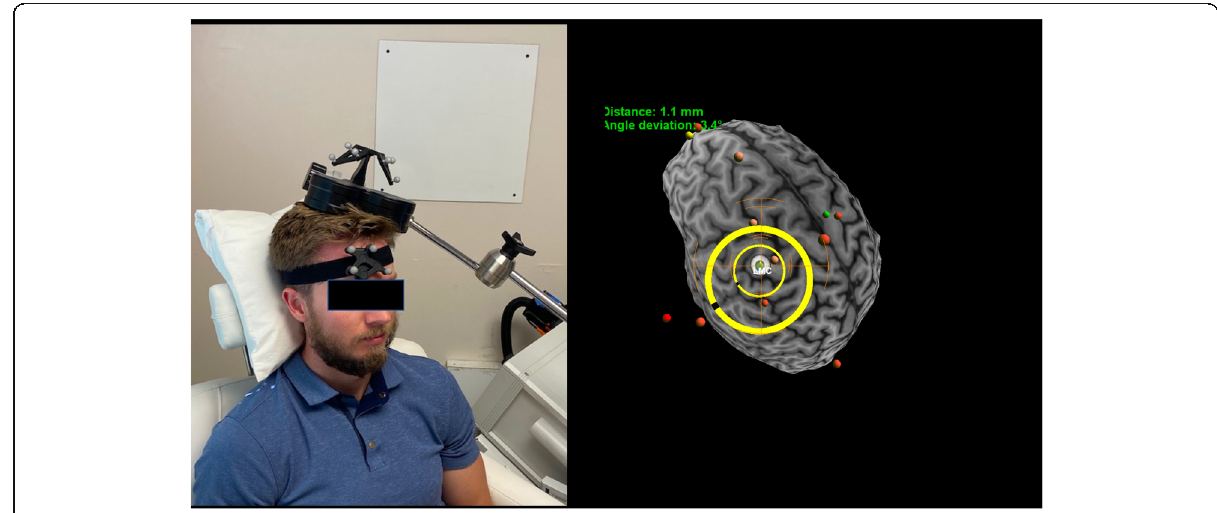
Fig. 2 Magnetic resonance imaging neuronavigation guided transcranial magnetic stimulation at the left primary motor